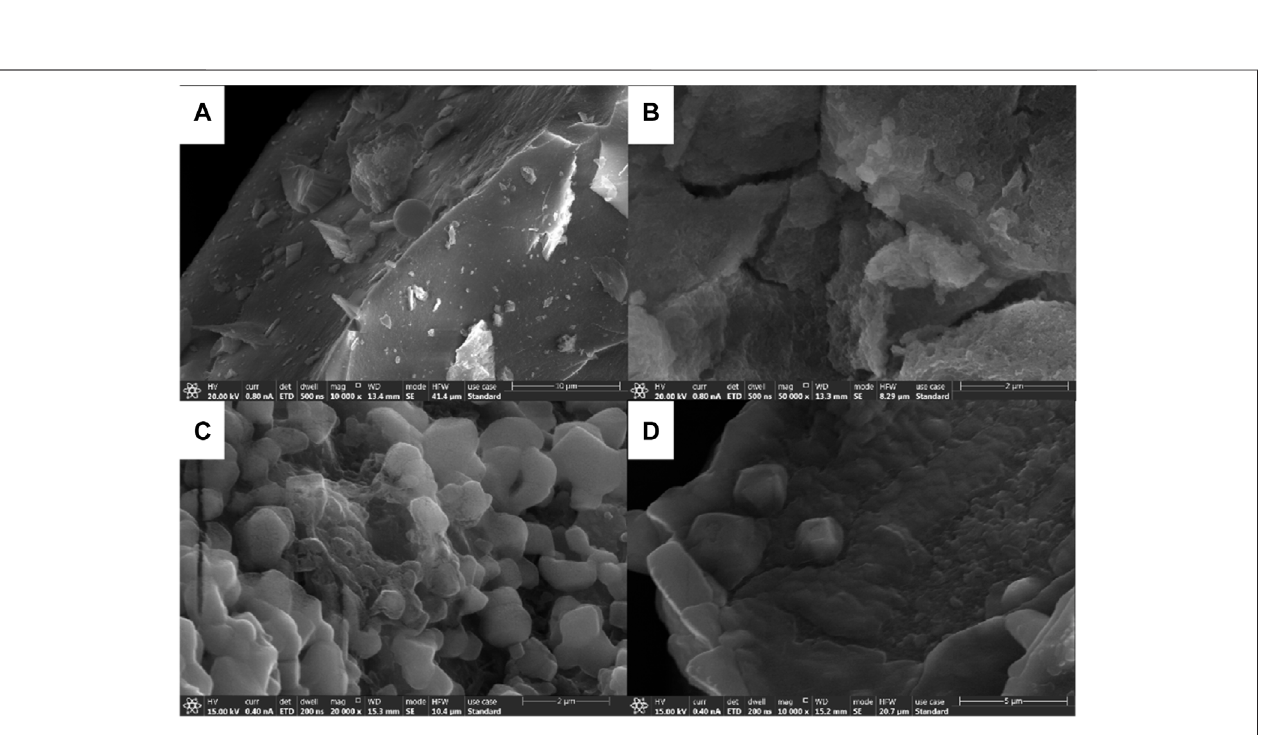
Frontiers in Materials |